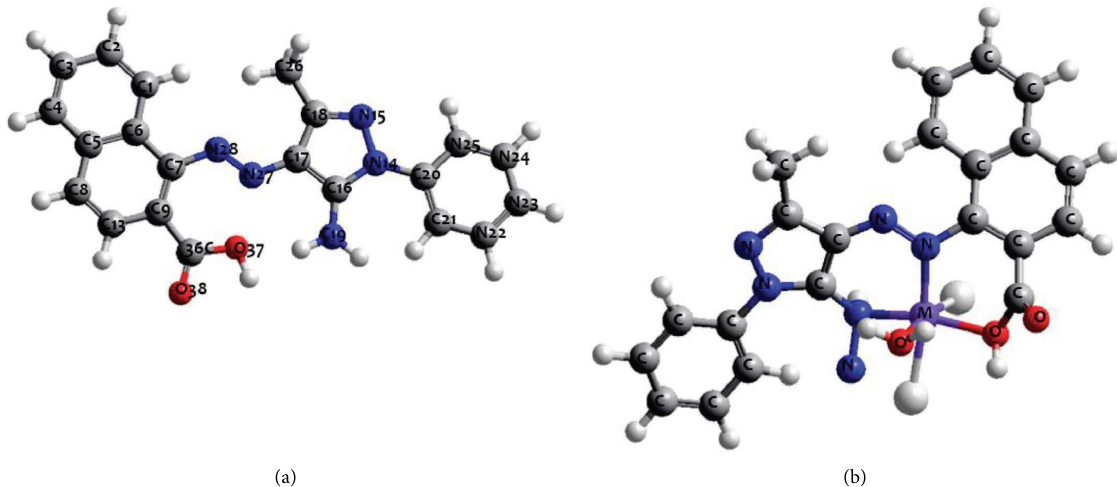
Figure 8: (a) Optimized geometry of the HL ligand atom numbering. (b) Optimized geometry of the complex where M is the metal atom Cu(II), Co(II), and Fe(II).